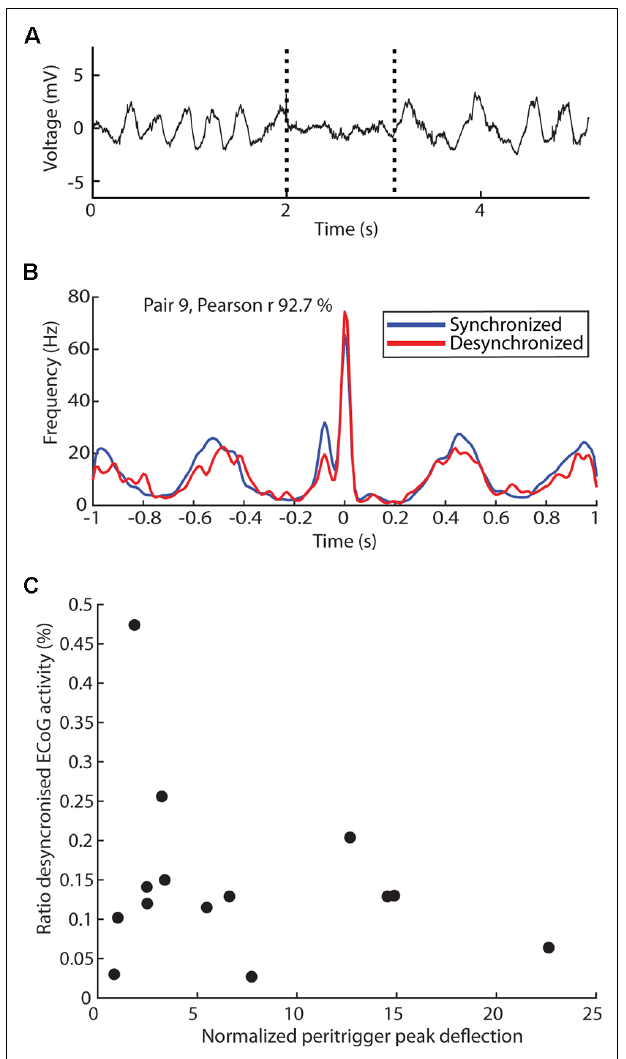
FIGURE 4 | The correlation patterns for each recorded neuron pair. The time ratio spent in the desynchronized ECoG state is indicated as a percentage. Asterisks ( ∗ ) are used to indicate the pairs of neurons which had one neuron which is defined as actively decoding the tactile afferent stimulation by having a decoding performance above our chance threshold level, two asterisks are used for pair 3 where both neurons surpassed this threshold (see Figure 5A ). Also indicated are the estimated thalamic locations of each thalamic neuron pair. VPM, ventroposterior medial nucleus; VPL, ventroposterior